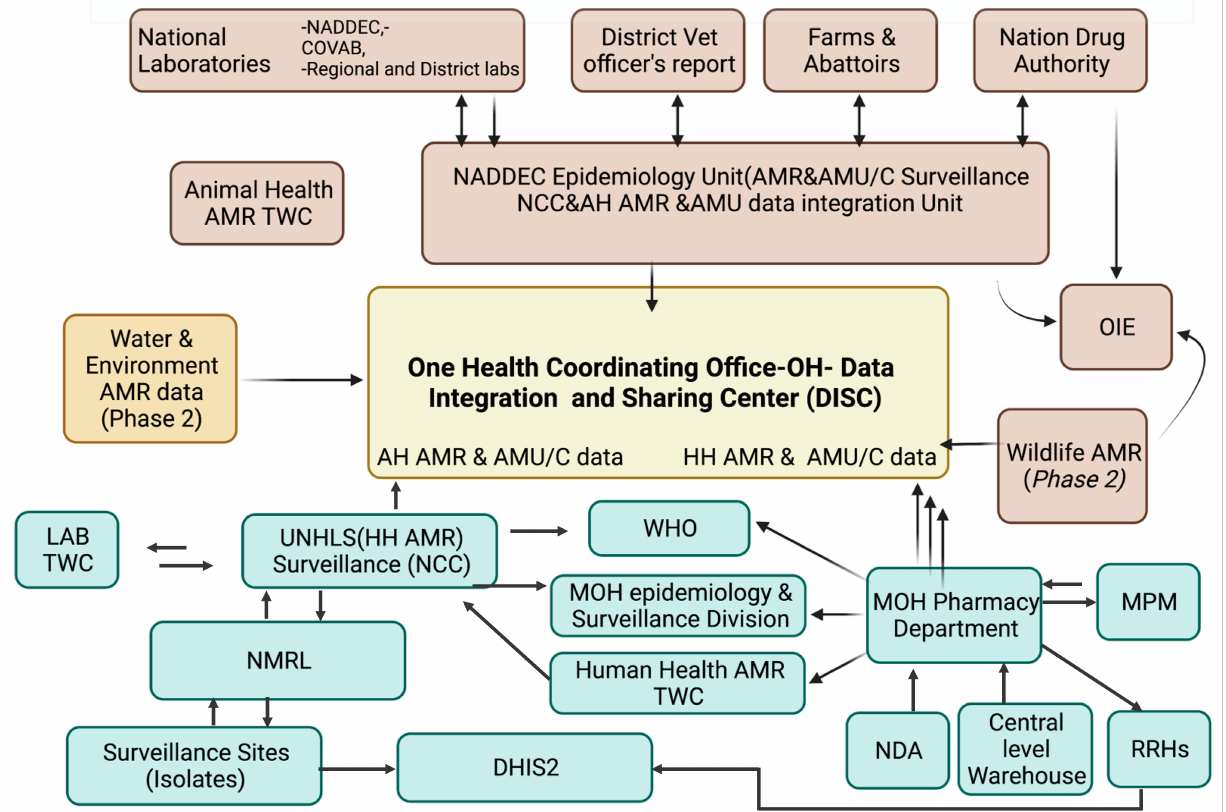
Figure 4. Illustration of the data sharing architecture with Human Health data linkages to One Health. This is colour coded according to the human health (green), animal health (brown), water and environment as a light brown